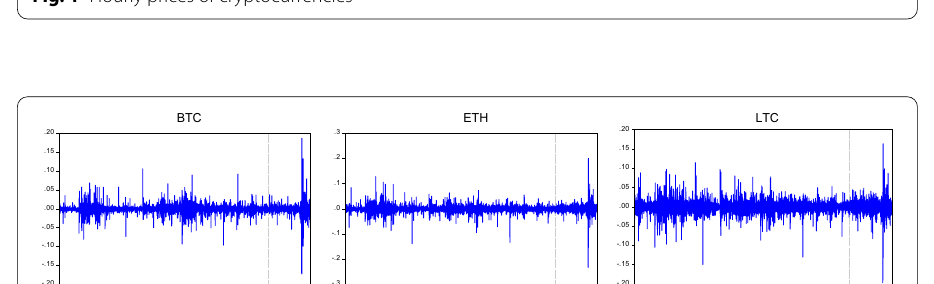
Fig. 2 Hourly returns of